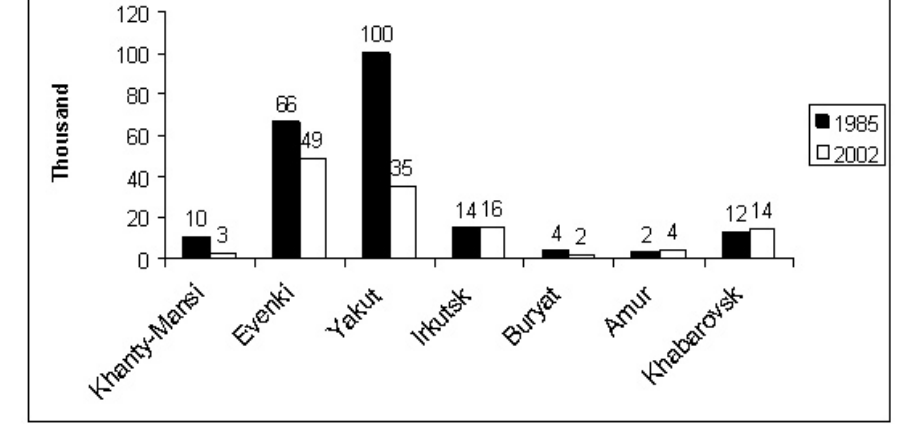
Fig. 2. Wild reindeer numbers in taiga regions (Syroechkovsky, 1986; Novikov, 1996b; Paponov, 2000; Fertikov et al. ,